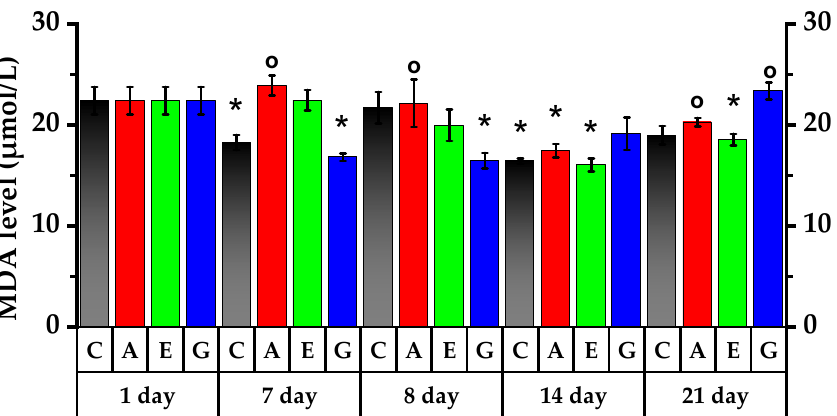
Figure 8. Malondialdehyde (MDA) level of peripheral blood of rats. * p < 0.05, significance of differences in animal groups compared to the 1st day of experiment. ◦ p < 0.05, significance of differences between animal groups compared to Control Group.